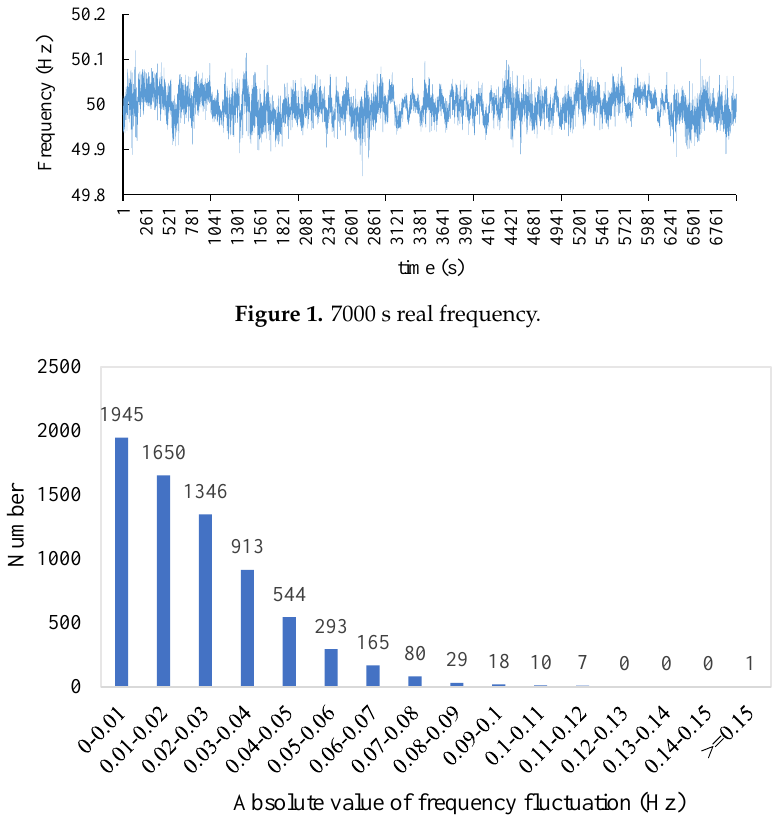
Figure 2. Measured frequency fluctuation statistics of power grid in 7000 s.